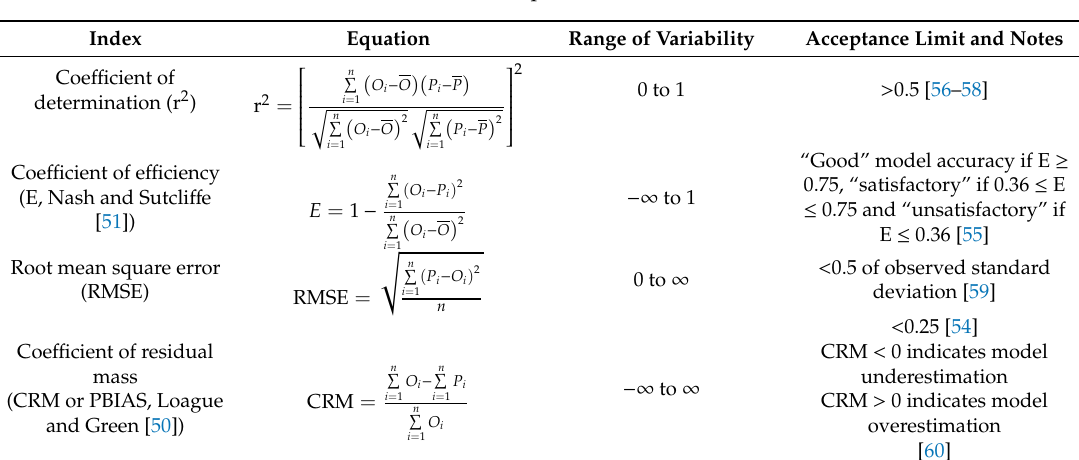
Table 4. Indexes and related equations and range of variability to evaluate the runo ff prediction capacity of the linear regression and curve number models in forest plots subject to prescribed fire and wildfire (Lezuza and Li é tor, Castilla La Mancha,